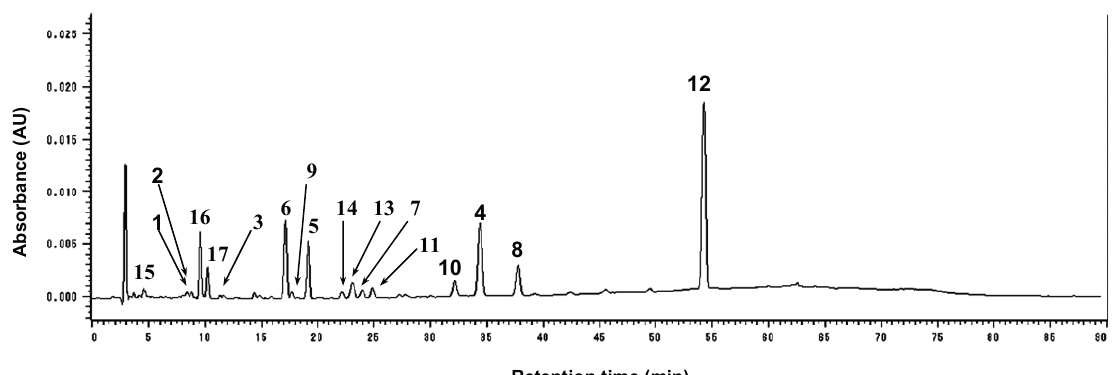
Figure 3. HPLC-UV chromatogram of P. corylifolia EtOAc extract at 280 nm a,b . a Column: YMC-PACK Pro-C18 (6.0 mm i.d. × 150 mm); mobile phase (gradient